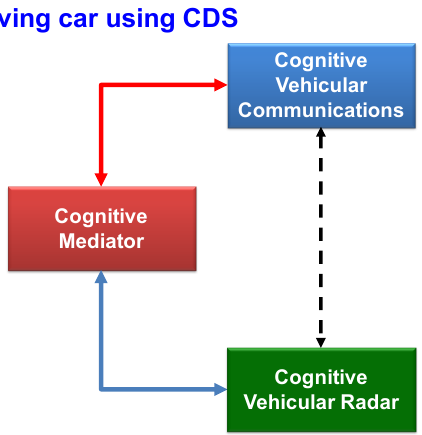
Figure 12. The fundamental layout of a coordinated vehicular radar and communication system.